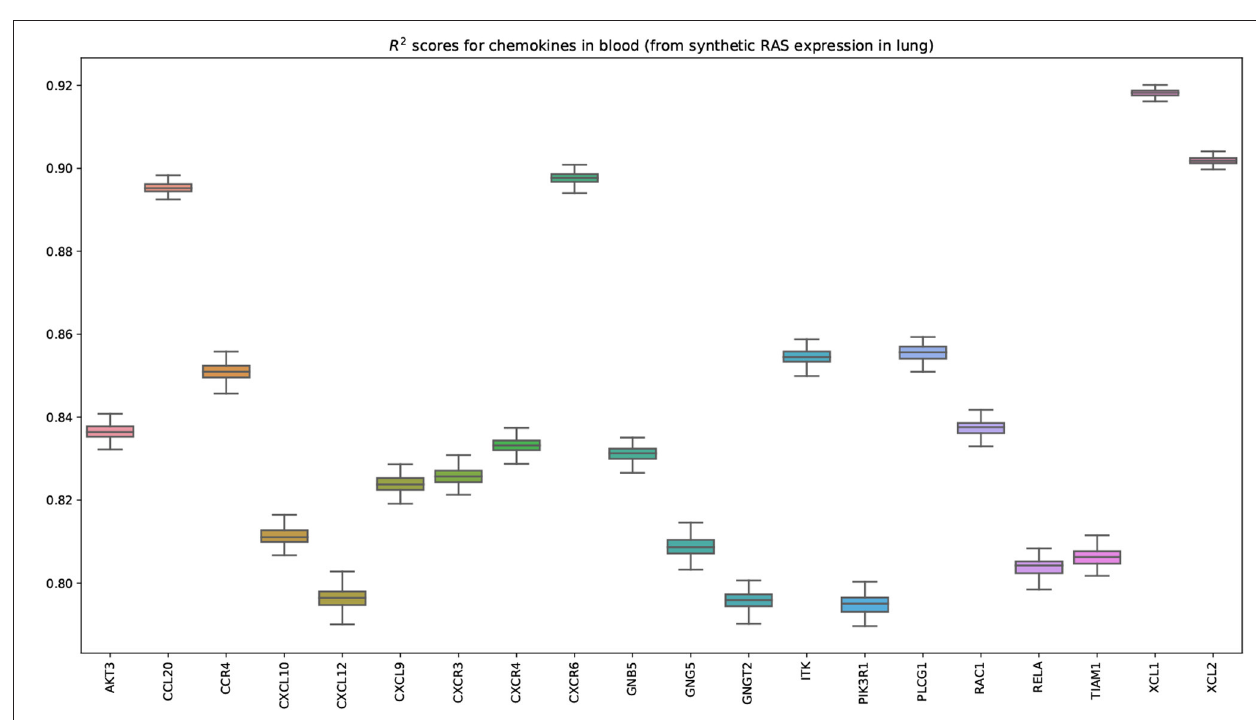
Frontiers in Genetics |